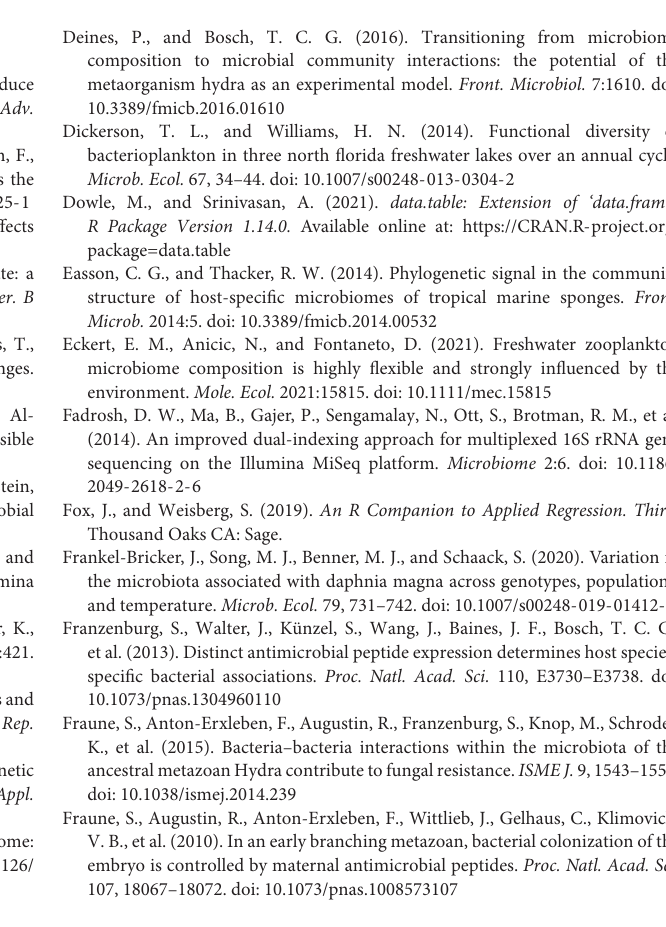
Supplementary Table 3 ) but not in multivariate PERMANOVA ( p = 0.59, Supplementary Table 3 )—this divergence is caused by perfect collinearity of sexual reproduction and H. circumcincta thus the difference is caused by the species effect on β -diversity. α -diversity changes with different species (E) and mode of reproduction (F) , but finds no statistical support in linear models ( p = 0.084, p = 0.093 for the univariate and multivariate linear model and species factor, p = 0.083 and p = 0.904 for univariate and multivariate model in reproduction, Supplementary Table 4 ). Supplementary Figure 8 | Analysis of individual population M90 recapitulates global patterns for species associated changes in the microbiota and no influence of reproduction on microbial changes. The different species form distinct clusters in UMAP representations (A) of β -diversity, while the effect is less clear in the PCA representation (B) which finds support in statistical analysis ( p < 0.001 in multivariate and univariate PERMANOVA respectively, Supplementary Table 3 ). Lower Bray–Curtis distances can be observed within H. circumcincta and H. vulgaris , while all other pairs display higher diversity changes (C) —notably also within H. oligactis pairs higher dissimilarity indices are present. There are no obvious differences in the Bray–Curtis distances for the different reproduction categories (D) , which is also reflected in the statistical test for influence of reproduction mode on microbial diversity ( p = 0.323 and p = 0.306 in univariate and multivariate PERMANOVA, Supplementary Table 3 ). α -diversity changes significantly with different species [ (E) p = 0.002 for the univariate and multivariate linear model, respectively, Supplementary Table 4 ] but do not display significant differences with changes in reproductive mode [ (F) p = 1 and p = 0.181